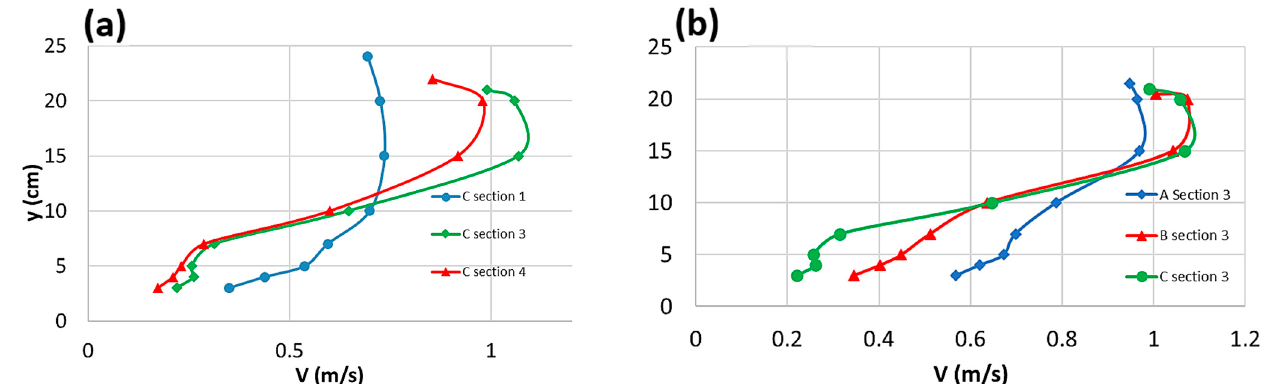
Figure 4. ( a ) The velocity profiles of the first, third, and fourth cross-sections of model type C, ( b ) The velocity profiles of type A, B, and C model vegetation at the third cross-section. velocity profiles of type A, B, and C model vegetation at the third